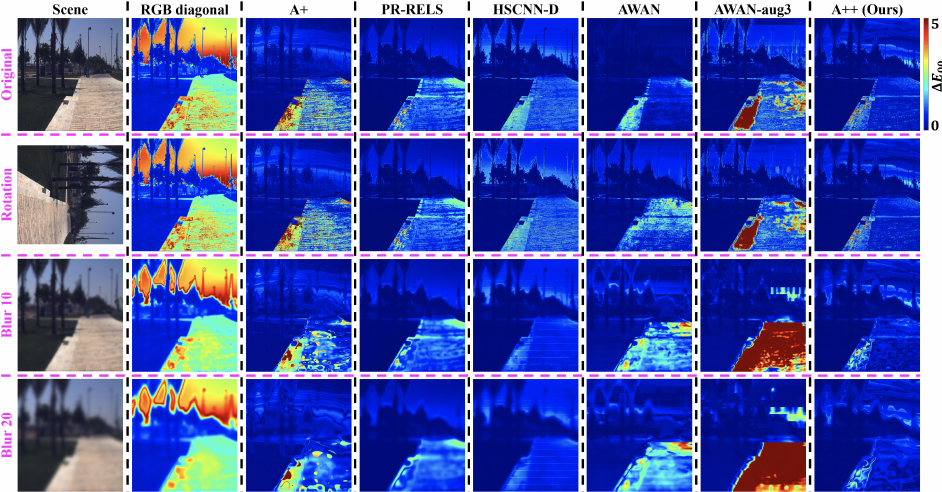
Figure 10. CIE Illuminant E scene relighting error heat maps in ∆ E 00 . The ground-truth relighted scene is shown in sRGB in the leftmost column. From the top to the bottom row, the tested imaging condition is in turn the original, rotation, and two Gaussian blur